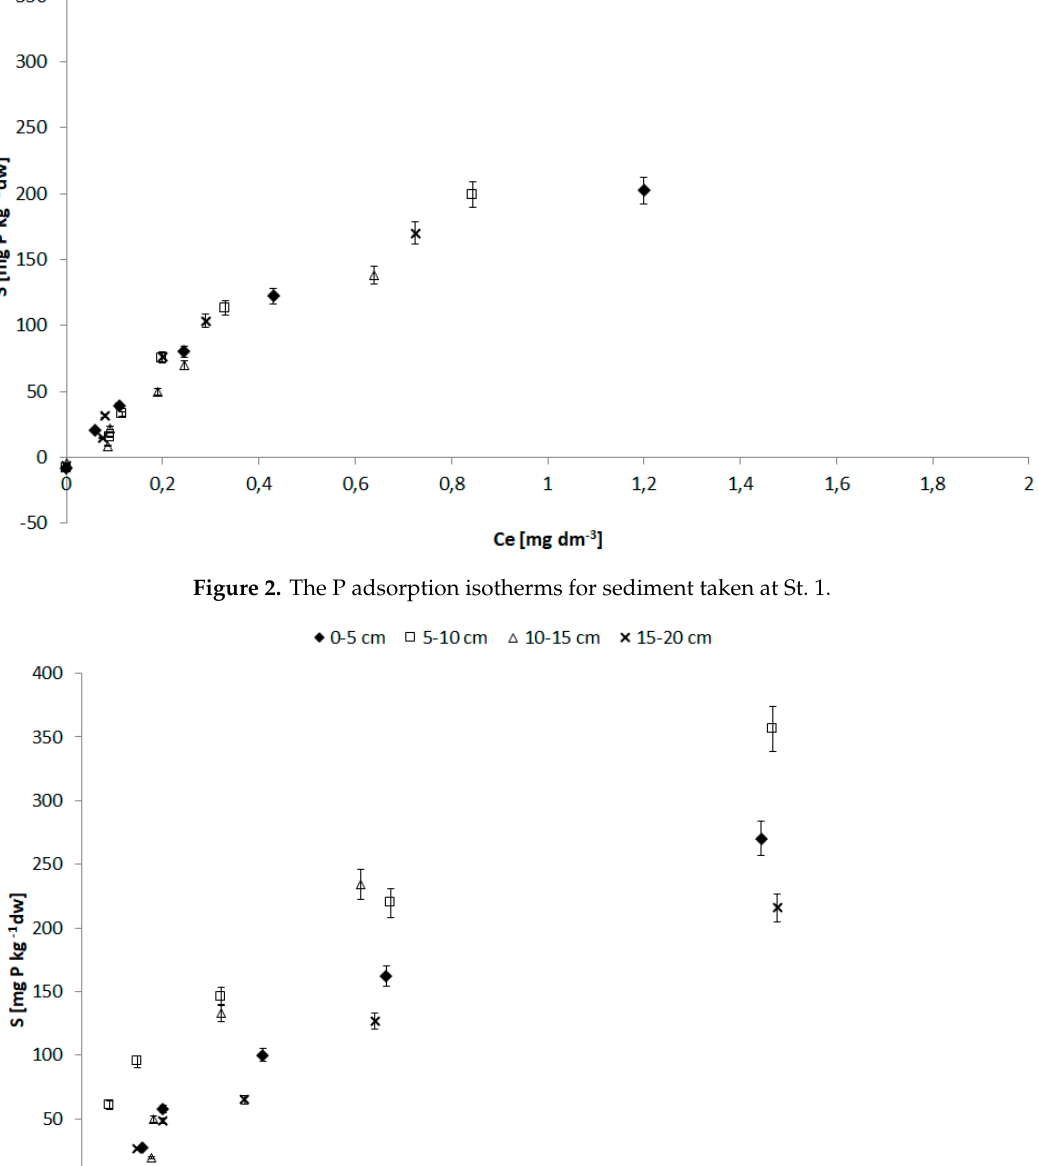
Figure 4. The P adsorption isotherms for sediment taken at St. 3. Table 1. The assessed values of Langmuir sorption model characteristics for profundal bottom sediment of D ł ugie Lake. Station